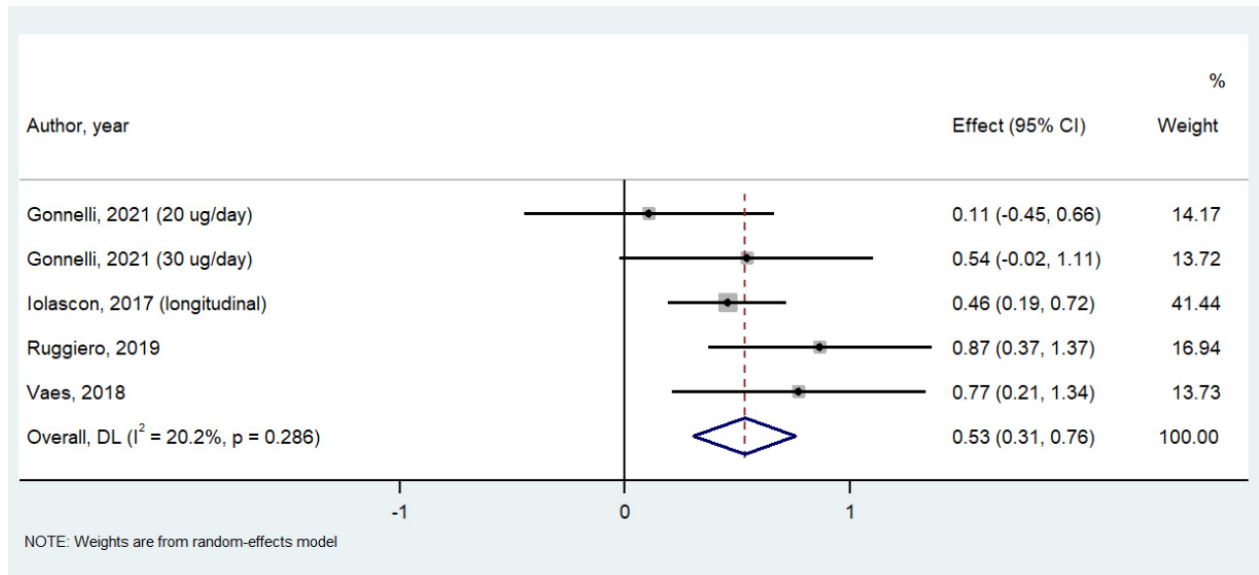
Figure 2. Forrest plot of the effect of calcifediol on handgrip strength. References [16,18,19,22].